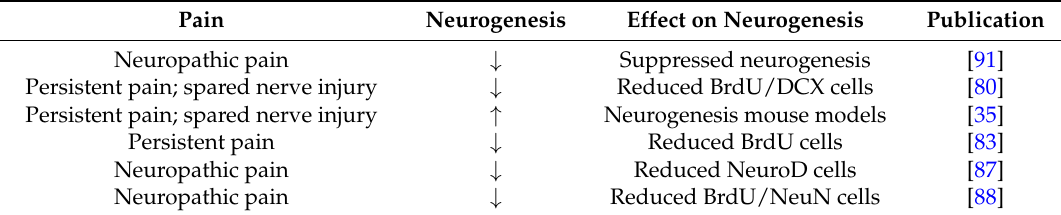
Table 1. Pain and